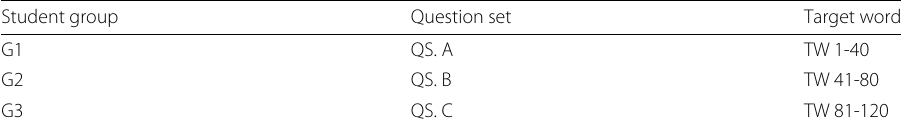
Table 4 Configuration of the question